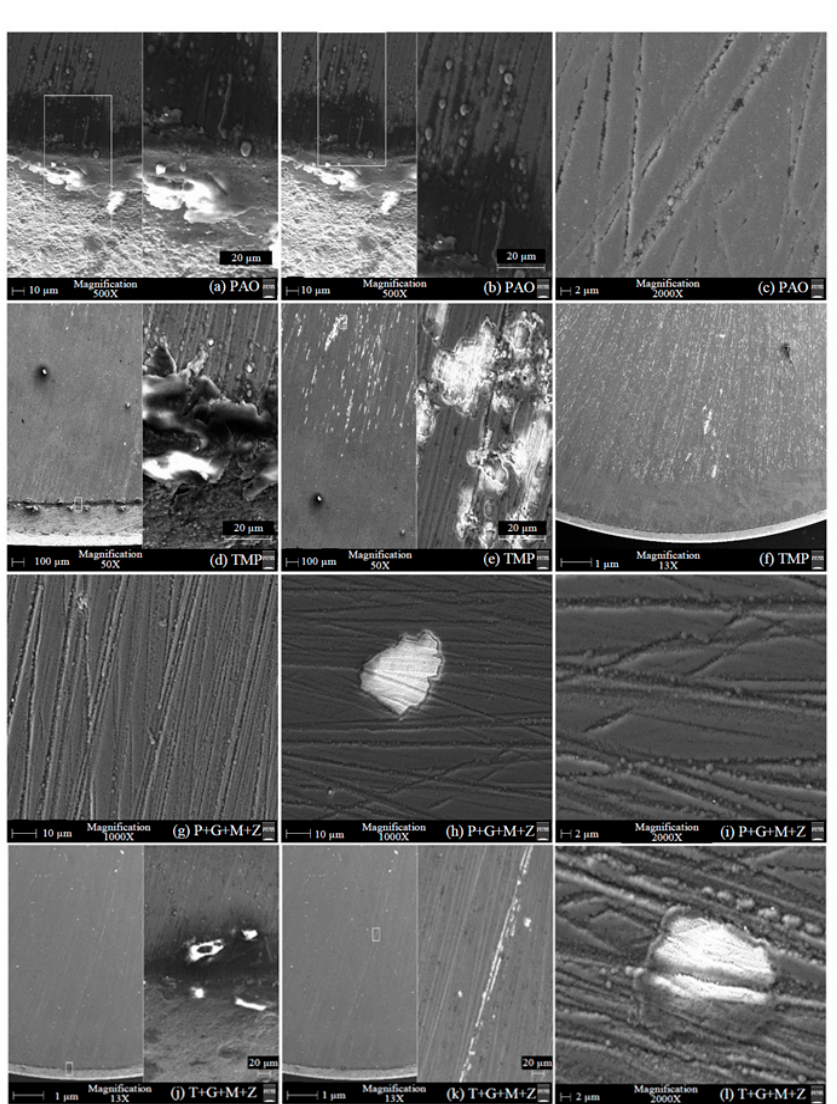
Figure 10. SEM micrographs of a-C:H-coated tappets after engine testing under various conditions in combination with a-C:H-coated camlobes with TMP-based and PAO-based lubricants.